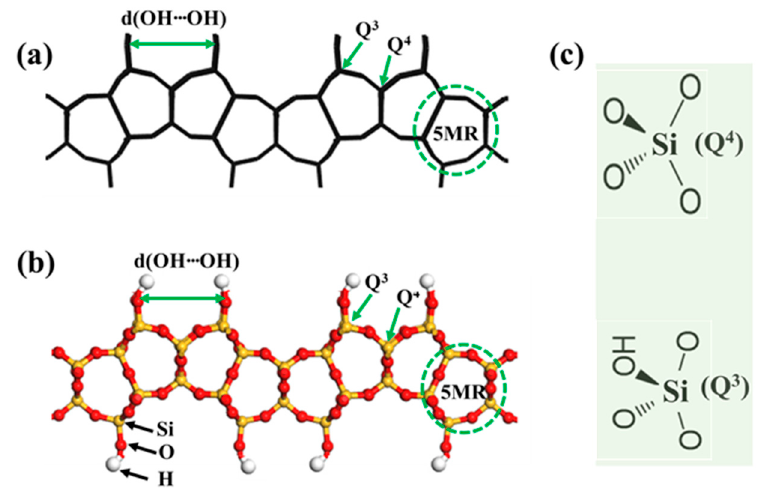
Figure 2. 2D layered zeolite precursor (e.g., PREFER (precursor of ferrierite) as an example) with highlights of the -OH group, d(OH ··· OH), Q 3 and Q 4 coordination structures, and the definition of member ring (MR) in zeolites. Both line ( a ) and ball–stick ( b ) display styles are included. ( c ) shows the Q 3 and Q 4 structures in zeolites or their precursors.